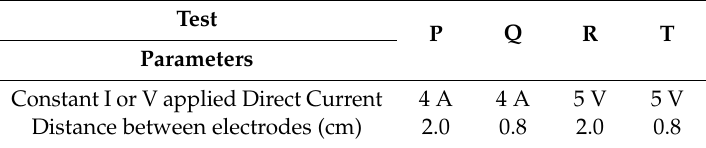
Table 1. Operational parameters and conditions for the EC tests.